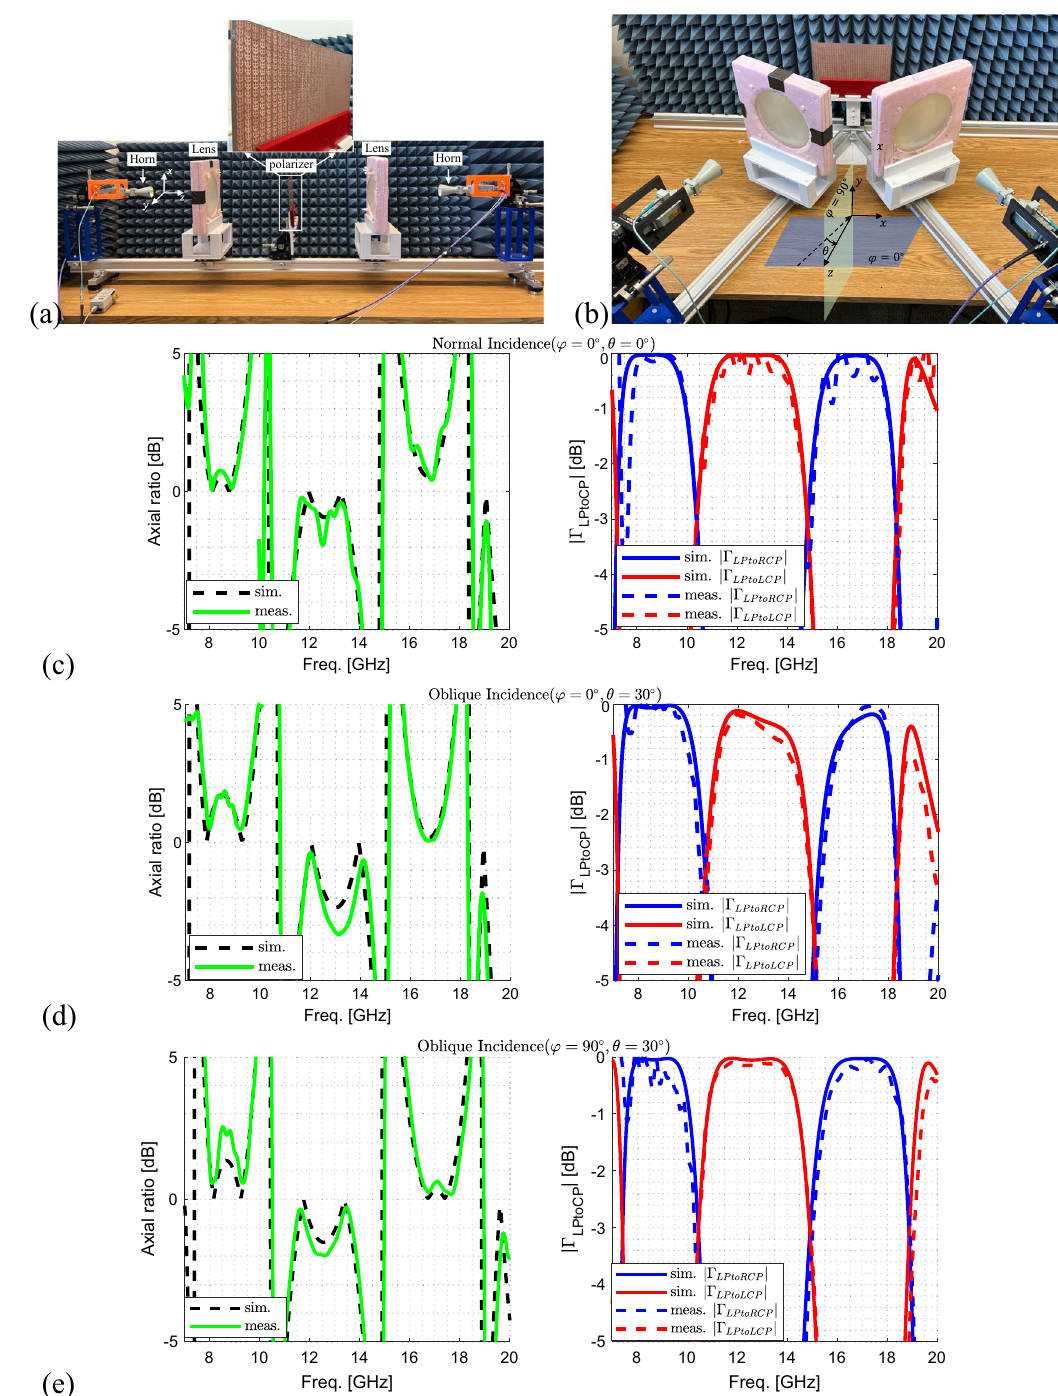
Figure 7. Quasi-optical setup for measuring reflection coefficients of the prototype under ( a ) normal incidence and ( b ) oblique incidence. The measured and simulated axial ratio and the LP-to-CP reflection coefficients of the optimized triple-band polarizer for ( c ) normal, and oblique incidence at ( d ) θ = 30 θ = 30 ◦ in ϕ = 90 ◦